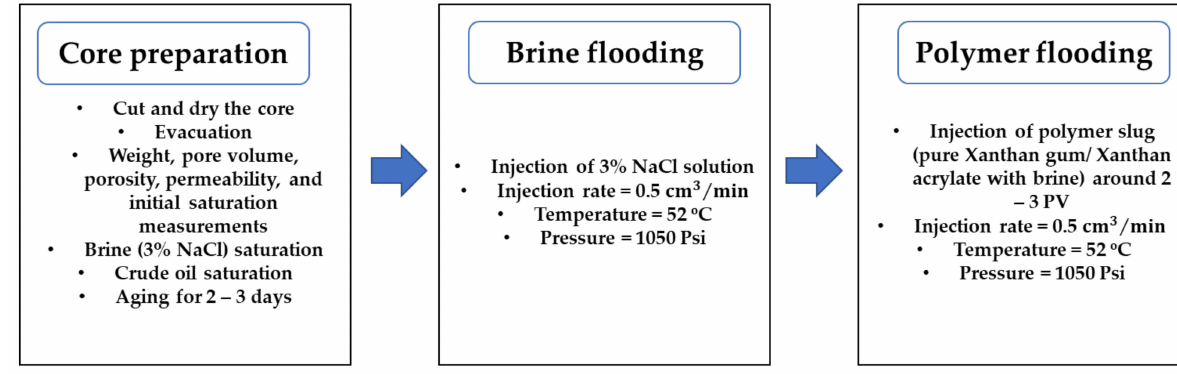
Figure 1. Process flow diagram of the polymer flooding experiment.